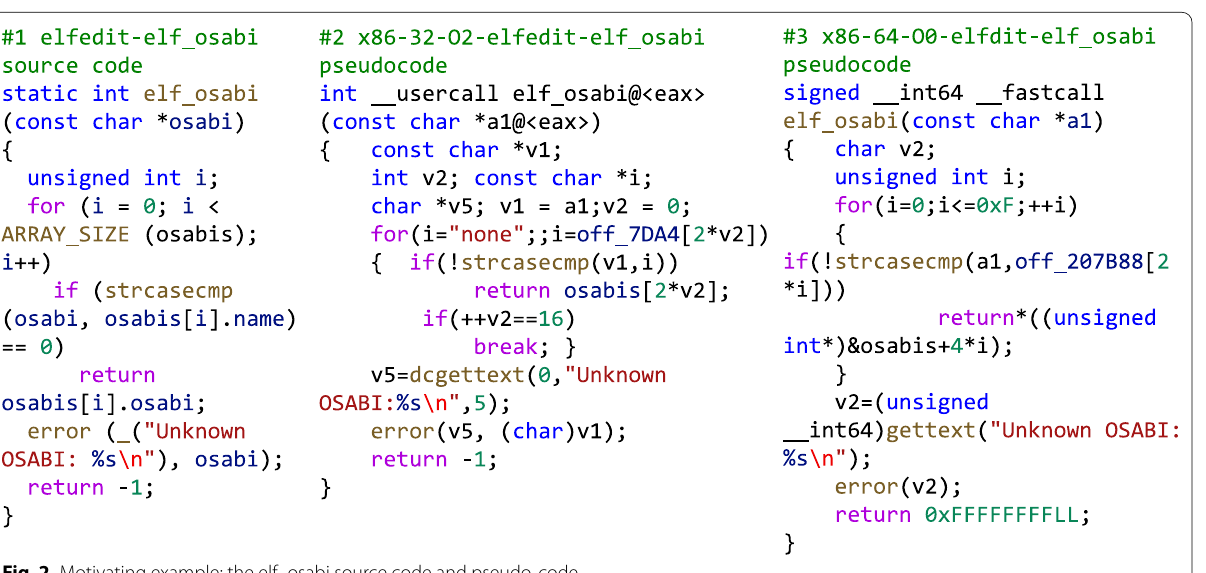
Fig. 2 Motivating example: the elf_osabi source code and